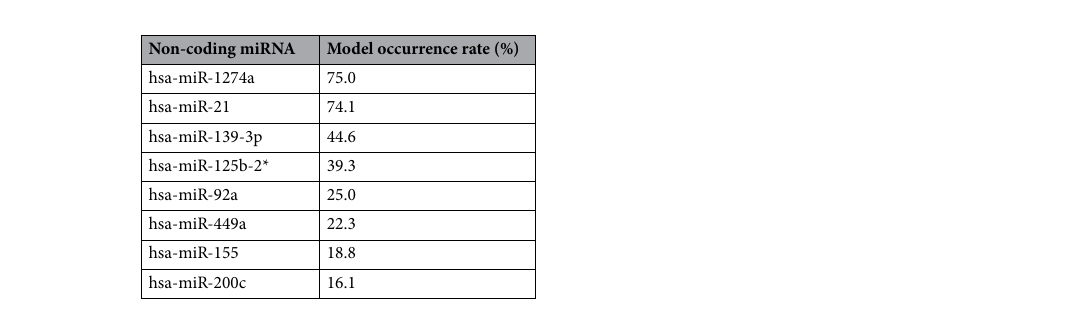
Table 2. Model occurrence rate of the most frequently selected